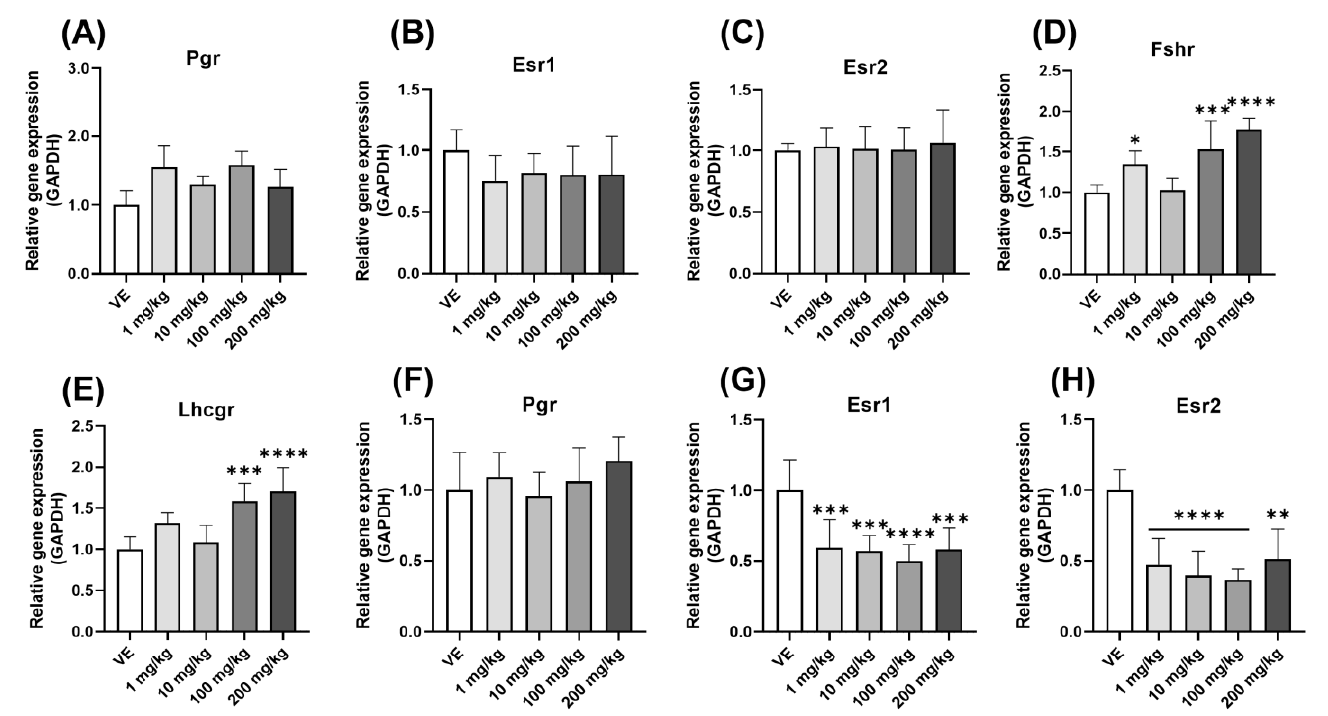
Figure 6. Changes in steroid hormone receptor expression by D5 exposure. Gene expression was confirmed using qPCR in the ovary and uterus of rats exposed to D5 for four weeks: ( A ) Pgr expres- sion level in the ovary; ( B ) Esr1 expression level in the ovary; ( C ) Esr2 expression level in the ovary; ( D ) Fshr expression level in the ovary; ( E ) Lhcgr expression level in the ovary; ( F ) Pgr expression level in the uterus; ( G ) Esr1 expression level in the uterus; ( H ) expression level of Esr2 in the uterus. The values are expressed as means ± SD. * p < 0.05, ** p < 0.01, *** p < 0.001 and **** p < 0.0001 vs. vehicle. VE—vehicle; Fshr—follicle-stimulating hormone receptor, Lhcgr—luteinizing hor- mone/choriogonadotropin receptor; N = 9~10.